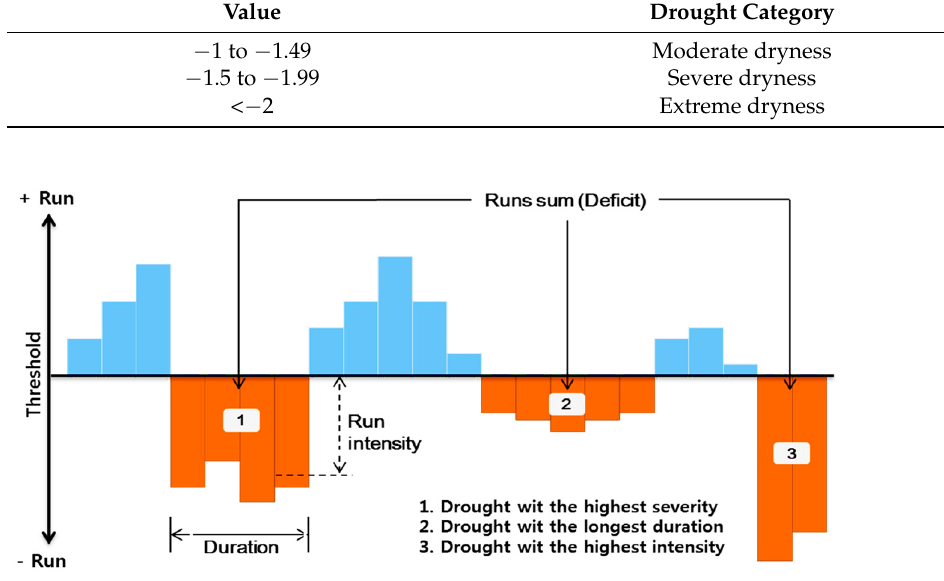
Figure 3. Drought characteristics using the run theory for a given threshold level [85].